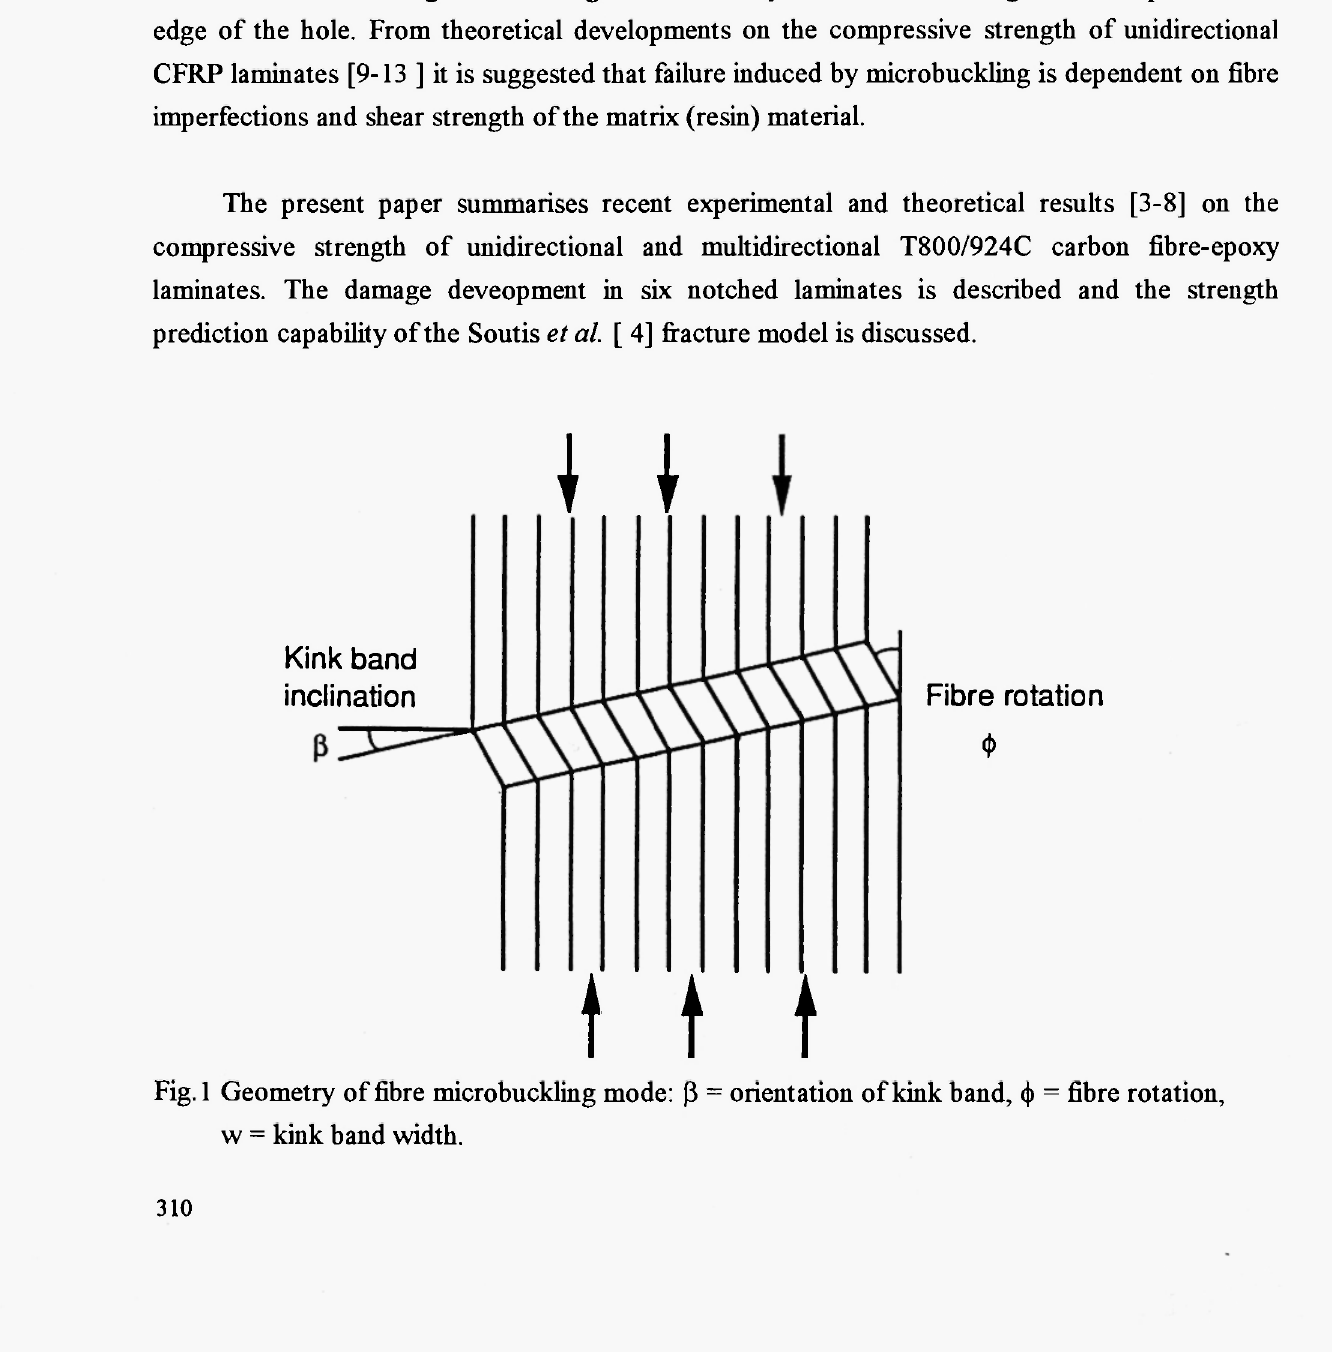
Fig. 1 Geometry of fibre microbuckling mode: β = orientation of kink band, φ = fibre rotation, w = kink band